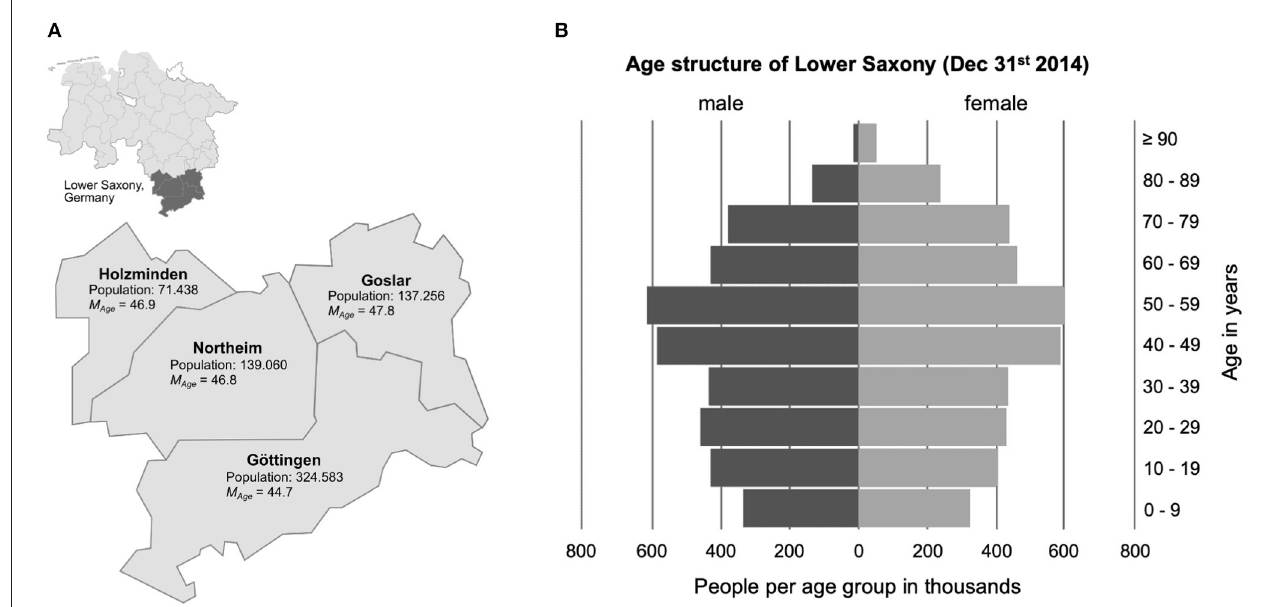
FIGURE 1 | (A) Display of the region in Lower Saxony, Germany, investigated in this study. The data on the number of inhabitants and mean age of each county are predictions for the year 2014, based on the German population survey “Zensus” from 2011. (B) Age structure of the State of Lower Saxony in 2014, as provided by the Landesamt für Statistik Niedersachsen (2016). The source materials for generating the map and the age pyramid were obtained from publicly available materials on